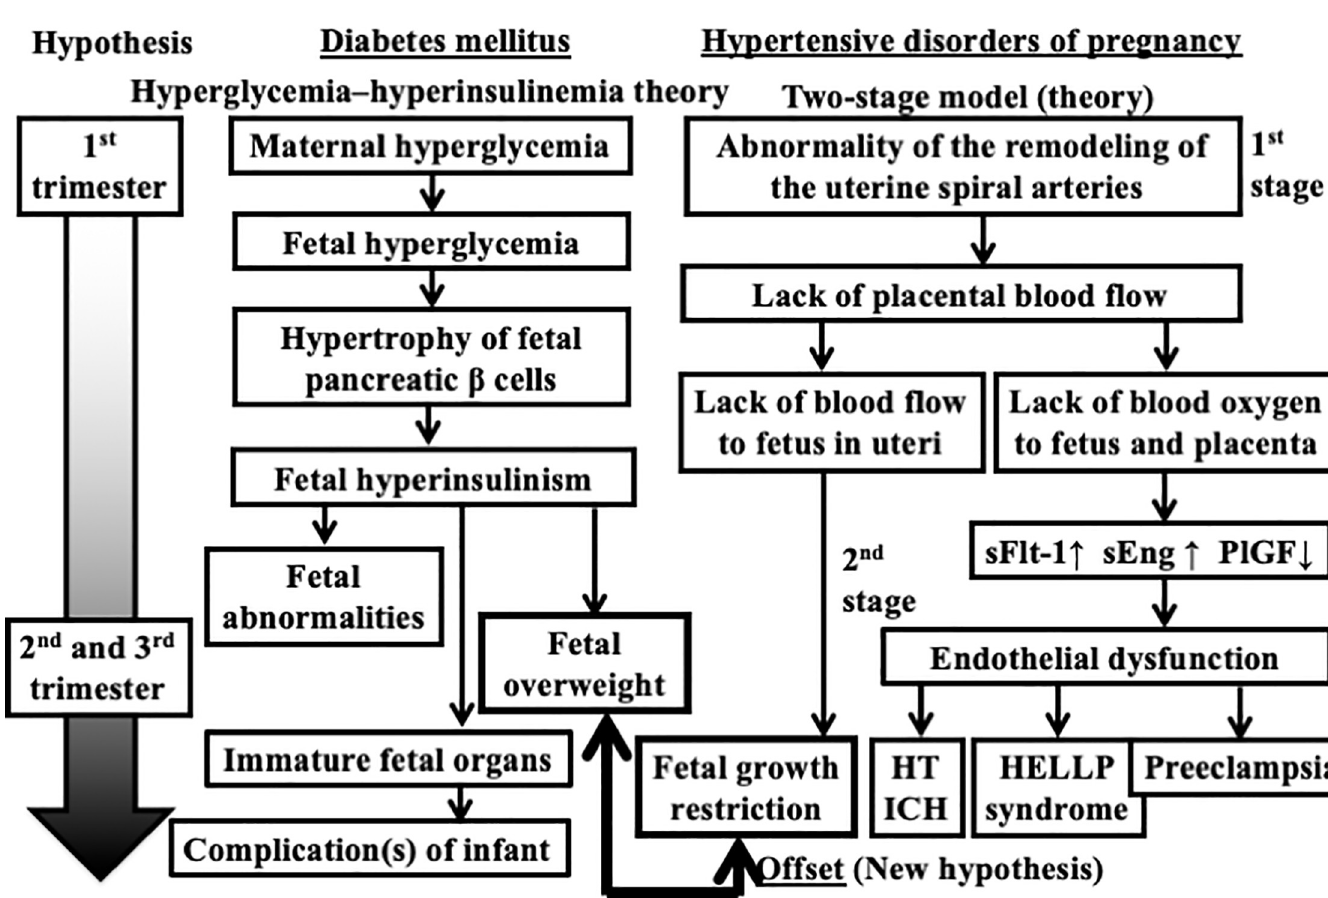
Fig 1. Hypothesis of diabetes mellitus (DM; left side) and hypertensive disorder of pregnancy (HDP; right side). The hyperglycemia–hyperinsulinemia theory for DM is a modified version of that described by Pedersen, [5] and the two-stage model for HDP (preeclampsia) is a modified version of that described by Roberts. [12] In this revised hypothesis, we propose that DM “normalizes” the fetal growth restriction induced by the onset of HDP. Abbreviations: GDM, gestational diabetes mellitus; HDP, hypertension disorders of pregnancy; ICH, intracerebral hemorrhage.